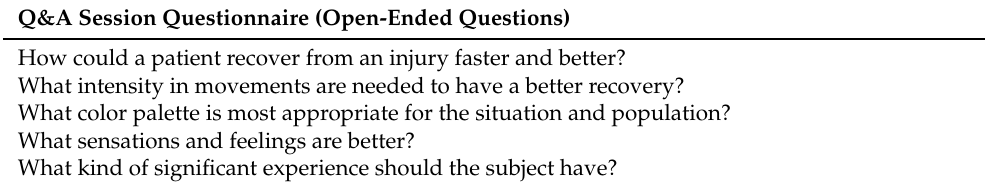
Table 1. Questions for the interdisciplinary group in the co-creation exercise. Q&A Session Questionnaire (Open-Ended